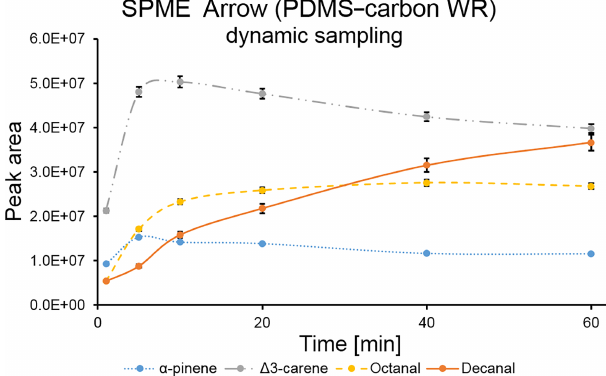
Figure 3. Comparison of the extraction efficiencies obtained with SPME Arrow and SPME fiber coated with PDMS–carbon WR and